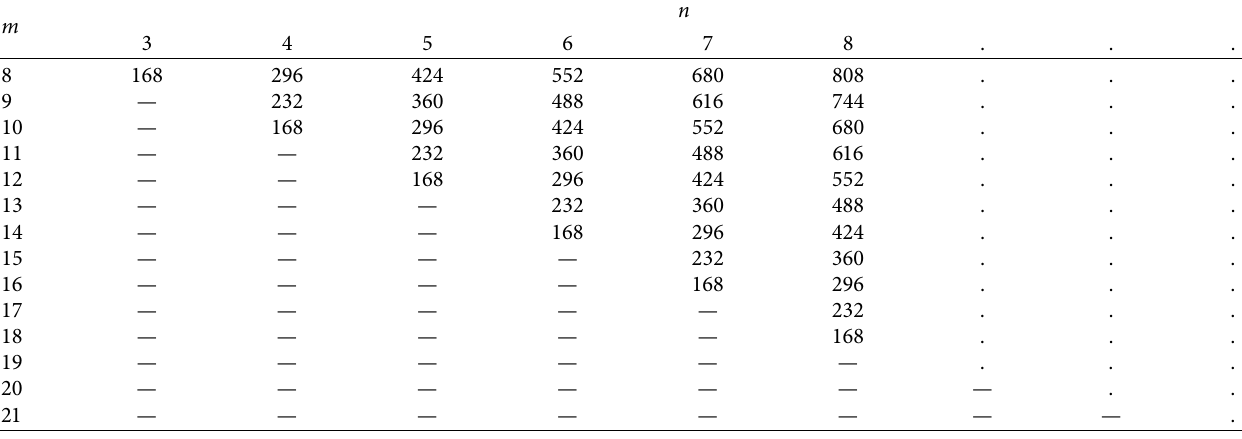
Table 2: Pair of vertices in HHC-1 at different